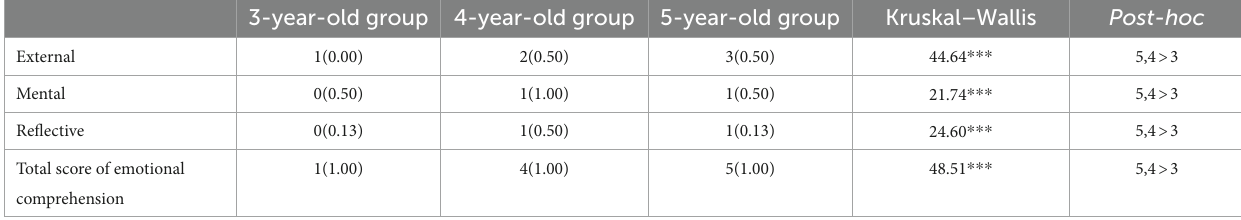
TABLE 4 Results of age difference on children’s emotional comprehension.